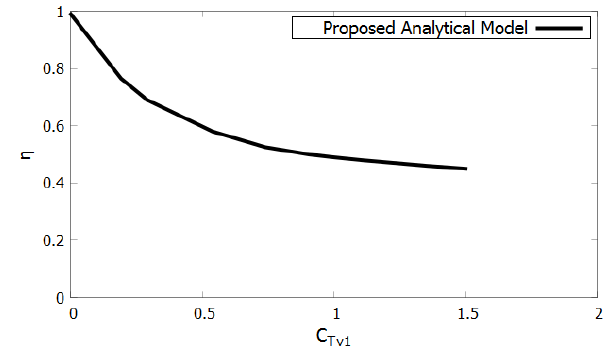
Figure 12. η as a function of loading.